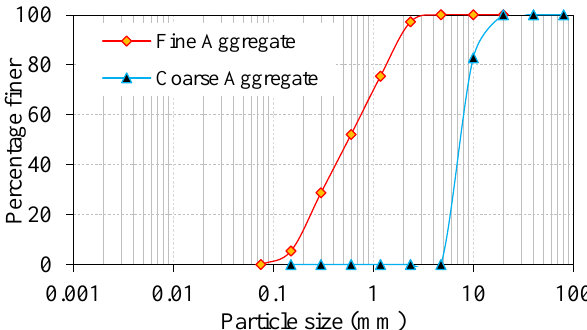
Figure 1. Aggregates particle size distribution.